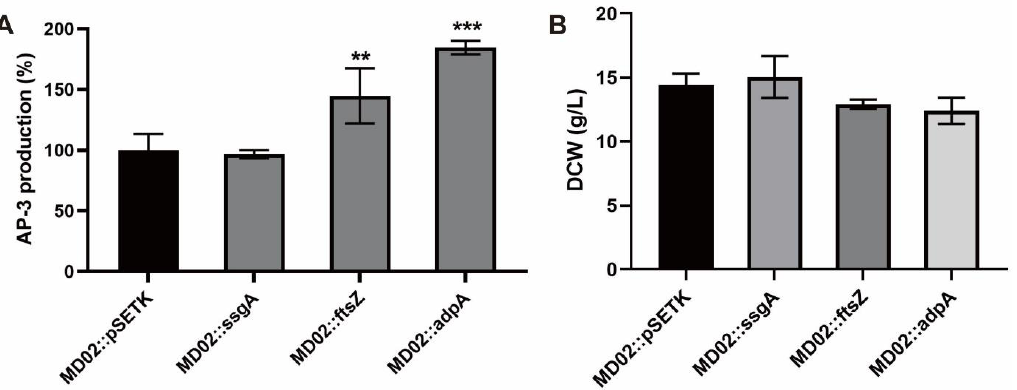
Figure 3. Effects of overexpression of cell division genes on AP-3 production ( A ) and cell growth ( B ). Three biological replicates were performed in fermentation experiments. The values are means ± SD of triplicate analyses. Differences were analyzed by one-way ANOVA, **, p < 0.01, ***, p < 0.001. 3.4. AdpA_1075 is Involved in the Regulation of ssgA_6663 Transcription in A. pretiosum The AraC family transcription factor known as AdpA is a global regulator of mor- phological differentiation and secondary metabolism [42,43,53,54]. Cell division genes are included in members of AdpA regulon, such as ssgA which requires AdpA to turn on transcription [28,50,55,56]. Since the fermentation morphology changes caused by ssgA_6663 inactivation did not directly affect the production of AP-3, we hypothesized that AdpA_1075 might be involved in both ssgA _ 6663 expression and ansamitocins production. Diametrically opposed transcriptional patterns of ssgA _ 6663 in adpA_1075 inactivation mutant seemed to further validate the hypothesis. In parent strain L40, the tran- scription of ssgA _ 6663 increased significantly on day 3 of fermentation, but decreased sharply when the strain switched to the stationary growth phase (Figure 4). In contrast, in mutant MD08, ssgA _ 6663 transcription was down-regulated due to the absence of AdpA_1075 and remained low from the third day of fermentation (Figure 4).